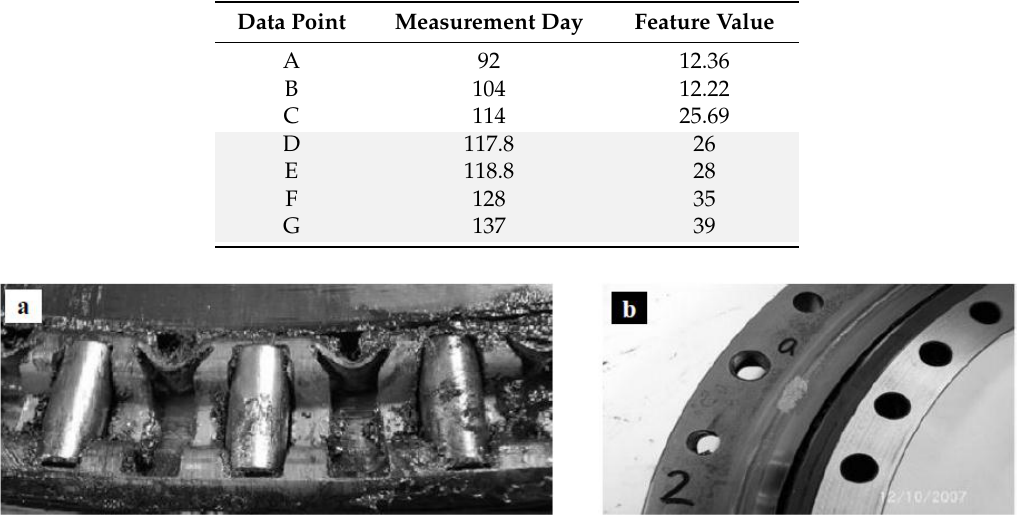
Figure 12. Slew bearing damage: ( a ) A view of damaged rollers in the axial plane; ( b ) Outer raceway damage.